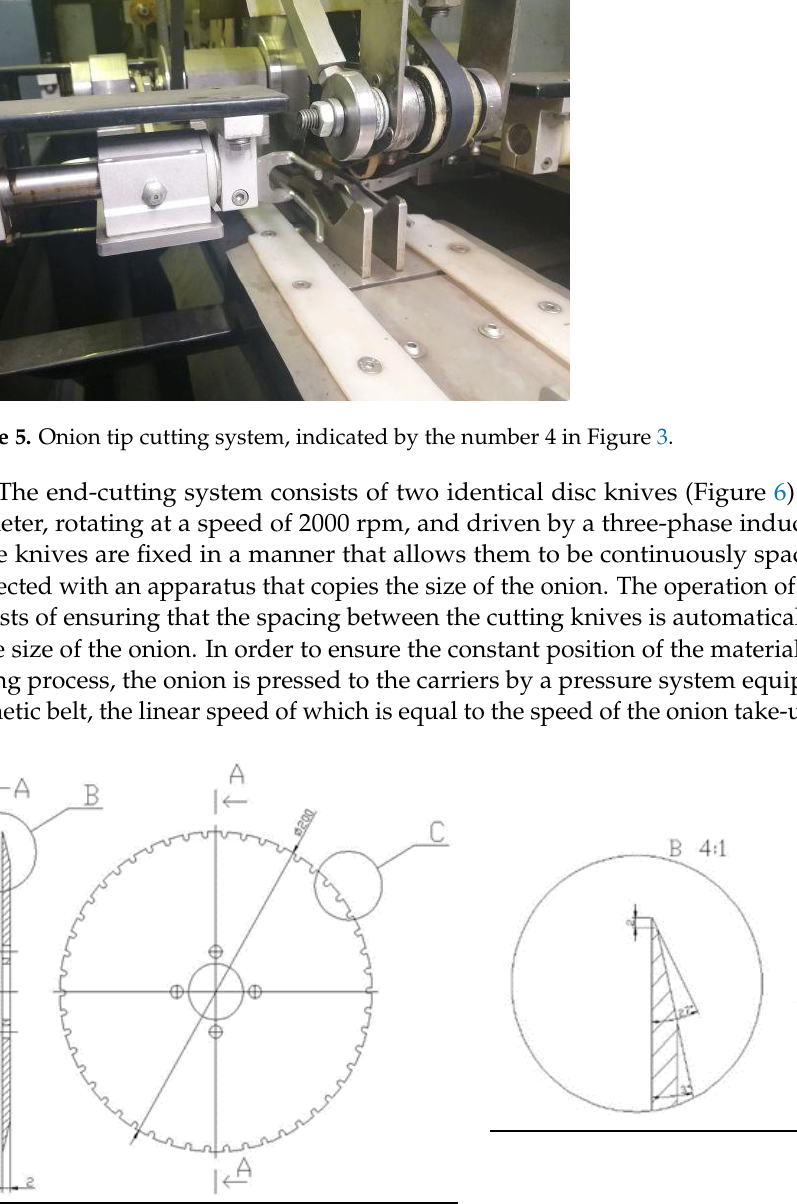
Figure 5. Onion tip cutting system, indicated by the number 4 in Figure 3.